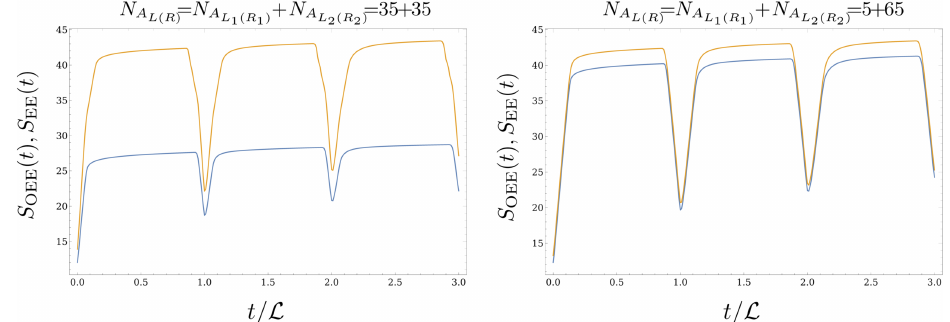
Figure 9 . The S EE (blue) and S OEE (orange) are presented for N =501 , m L =10 − 3 , d =0 , β =10 − 2 L